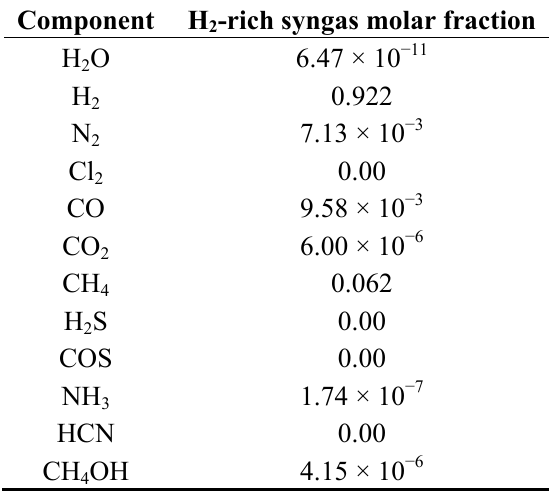
Table 6. H -rich syngas molar 2